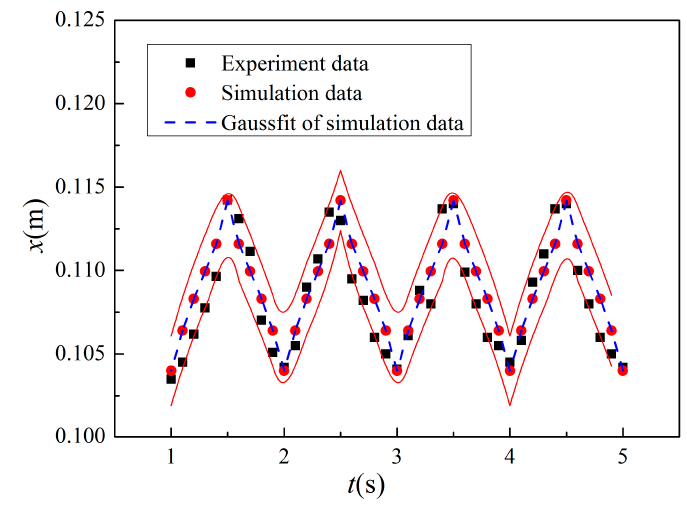
Figure 9. Position variation of the impinging surface during many periods, as determined by PIV and a CFD model, at u m = 1.25 m/s, T = 0.4, A = 0.25 m/s, L/D = 4 and ∆ ϕ = T /2; N is the number of periods; the area formed by the red line is the allowable error range between simulation and experiment data.